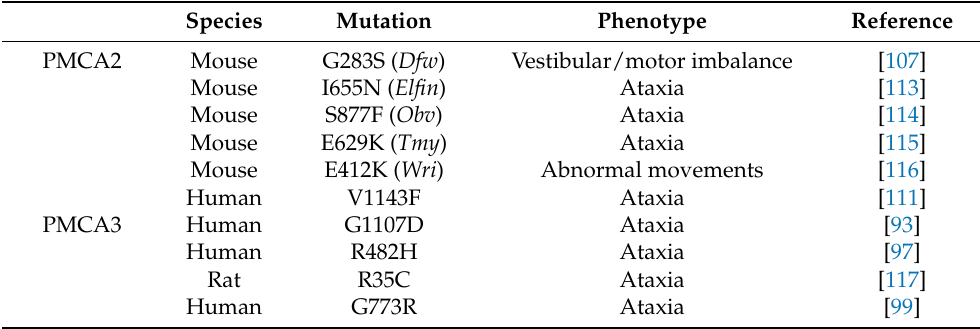
Table 2. List of PMCA mutations and associated phenotype. Modified based on